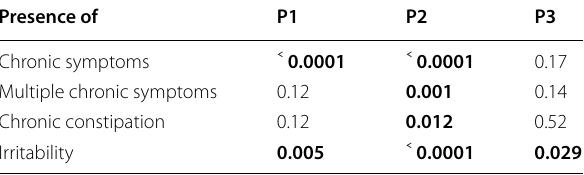
Table 7 Post hoc analysis of the incidence of the chronic symptoms of the groups in the study